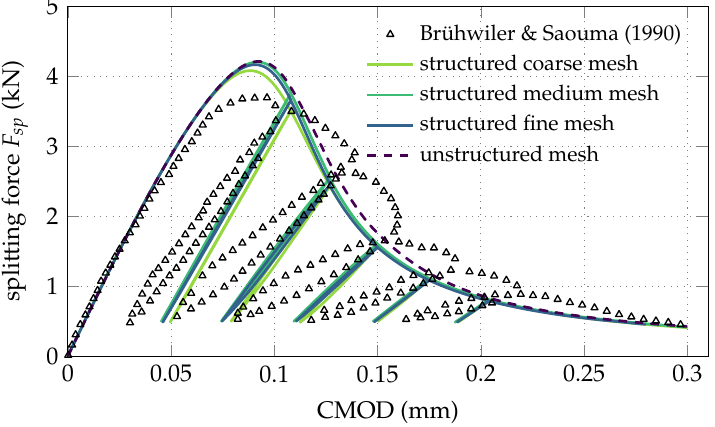
Figure 3. Splitting force vs. crack mouth opening displacement (CMOD) for the wedge splitting test: experimental results (data taken from [40]) and numerical